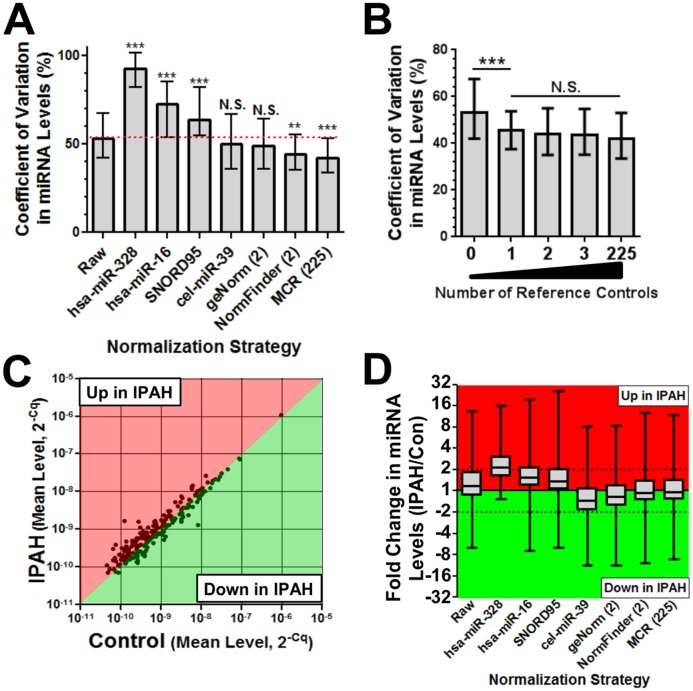
Characterization of reference control performance in the PAH screening cohort.
A. Effect of different normalization strategies on the coefficient of variation (CV) in miRNA levels across subjects (n = 7 subjects). Raw refers to non-normalized data. geNorm (2) denotes geomean of reference miR candidates (miR-766 and -3909) identified by this alternative algorithm [25]. NormFinder (2) denotes geomean of miR-142-3p and miR-320a. MCR225 denotes the geomean of all 225 RNAs (i.e., 224 miRNAs + SNORD95) comprising the initial pool of candidate reference controls. Each bar represents the median CV in plasma level of 225 RNAs (error bars = interquartile range). Kruskal-wallis test was performed with Dunn's multiple comparison post hoc test. ** p<0.01, *** p<0.001 versus raw data. Red dotted line denotes reference level to raw data. NS denotes not significant. B. Effect of increasing number of reference controls on CV in miRNA levels (0 = raw, 1 = miR-142-3p, 2 = geomean of miR-142-3p & miR-320a, 3 = geomean of miR-142-3p, miR-320a & miR-222-3p). Each bar represents the median CV in plasma level of 225 RNAs (error bars = interquartile range). *** p<0.001 versus 0 reference controls. C. Scatterplot of raw non-normalized plasma levels of 225 RNAs in the initial pool of candidate reference controls. Each dot represents the mean expression level (in 2-Cq units) of a specific miRNA in the IPAH versus Control groups of the screening cohort. Unchanged miRNAs lie on the diagonal line that divides the red (up-regulated miRs) and green (down-regulated miRs) regions of the graph. The distribution of raw miR levels is asymmetrical and skewed toward a higher proportion of up-regulated miRNAs in IPAH. D. Effect of normalization strategy on the distribution of up and down-regulated miRNAs. Each boxplot represents the distribution in fold change values for the 225 RNAs (mid line = median, box = interquartile range, whiskers = min and max). The dataset in panel C corresponds to the 'raw' boxplot in panel D, which shows an upward shift above zero. The results of normalizing the data to several other micro- or small RNAs are included for perspective.